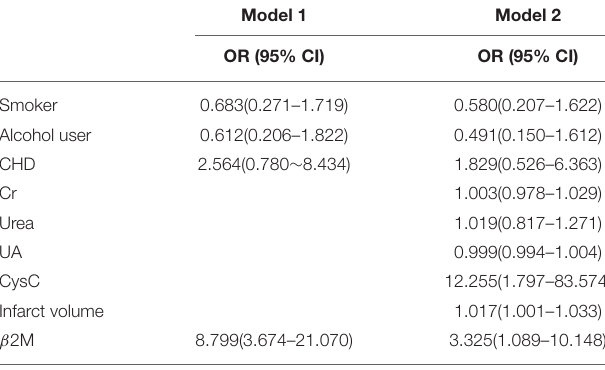
TABLE 4 | Risk factors for poor 3-month outcomes in acute ischemic stroke (AIS) patients according to binary logistic regression analysis ( N = 205).